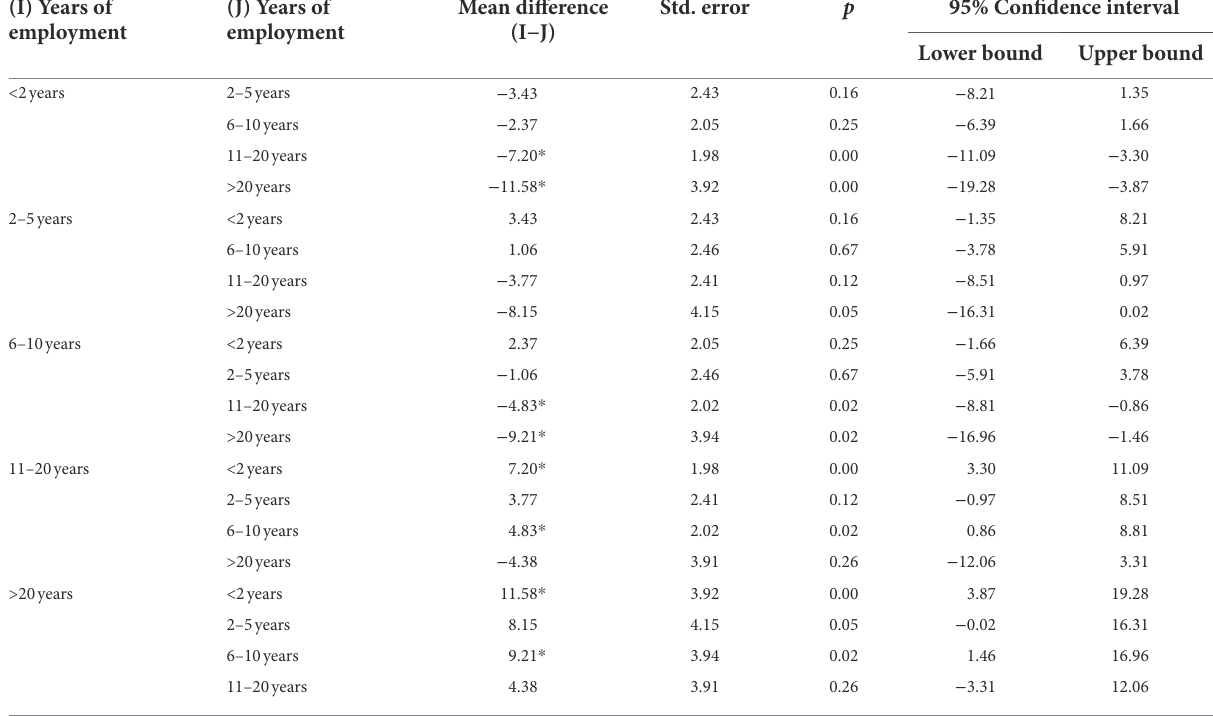
TABLE 5 Multiple comparisons of psychological capital scores of nurses with different years of employment. (I) Years of (J) Years of employment